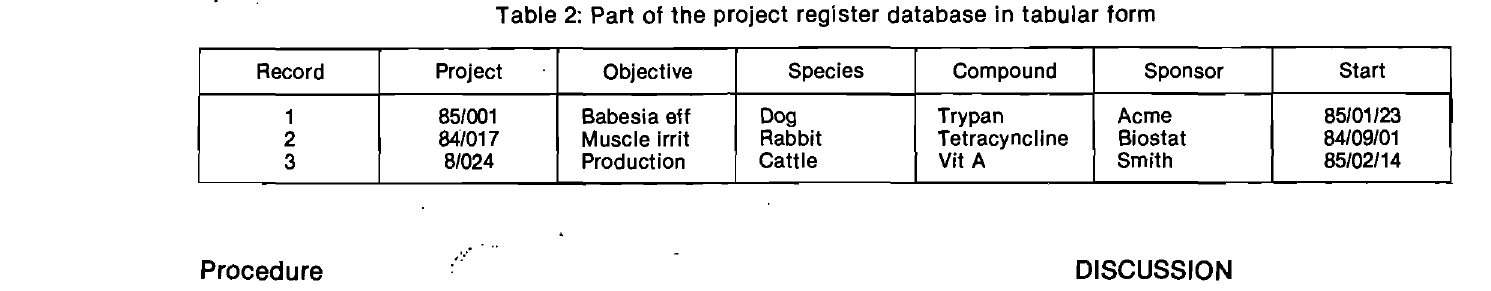
Table 2: Part of the project register database in tabular form